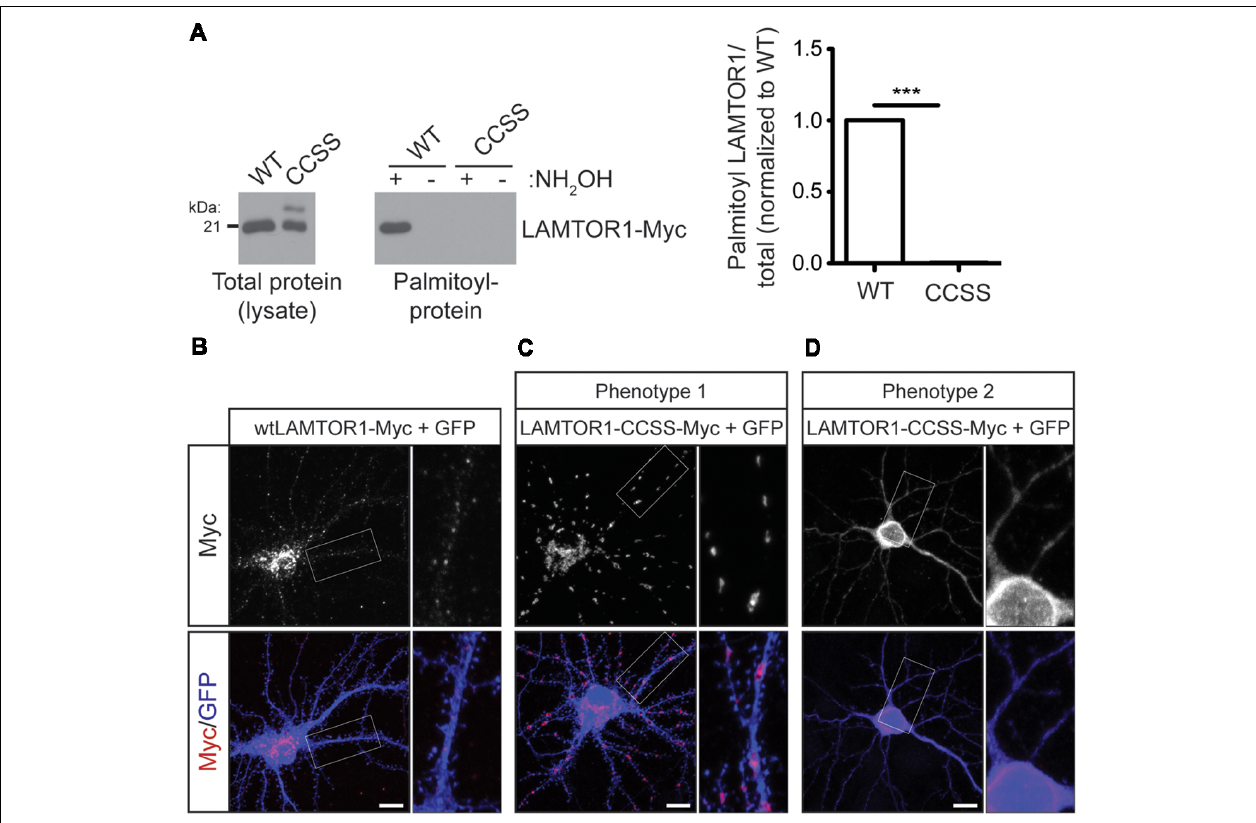
FIGURE 6 | Palmitoylation is required for LAMTOR1 localization in hippocampal neurons. (A) Mutation of cysteines 3 and 4 in Myc-tagged human LAMTOR1 (LAMTOR1-CCSS-Myc) abolishes its palmitoylation. Total expression (left panel) and palmitoyl-levels (right panel) of WT or CCSS LAMTOR1-Myc isolated from transfected HEK293T cells. Right histogram shows quantified palmitoyl/total LAMTOR1 levels (Student’s t -test with Welch’s correction, ∗∗∗ < 0.001, N = 3). (B) Hippocampal neurons were transfected to express wtLAMTOR1-Myc and morphology marker GFP. First column : images of Myc and merged images of Myc/GFP signals. Second column : magnified views of the boxed area of first column images. (C,D) As in A except that neurons were transfected with LAMTOR1-CCSS-GFP. (C) Phenotype 1 of LAMTOR1-CCSS-Myc, observed in approx. 85% of neurons and (D) phenotype 2 of LAMTOR1-CCSS-Myc, observed in approx. 15% of neurons. Scale bar indicates 10 µ